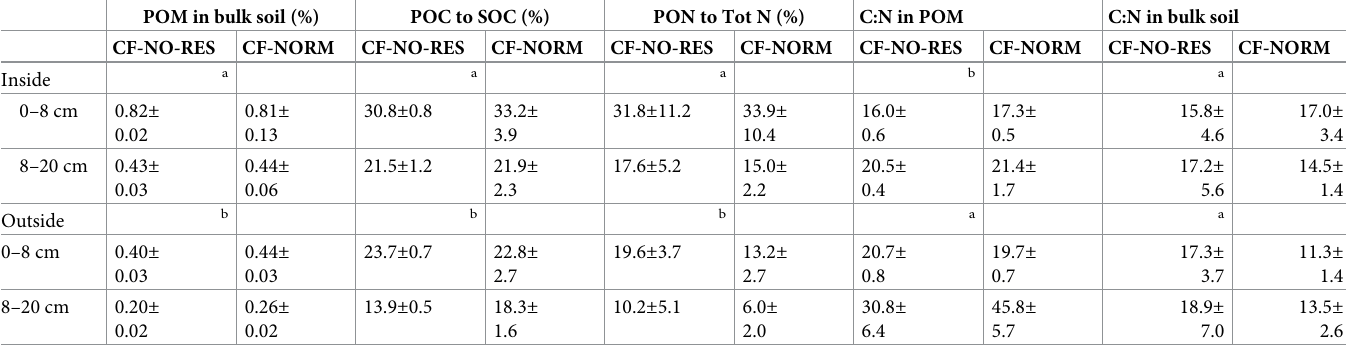
Table 2. Particulate organic matter in the bulk soil, contribution of particulate organic C (POC) to SOC, contribution of particulate organic N (PON) to total N and CN ratio in POM in CF-NORM and CF-NO-RES inside and outside basins at 0 to 8 cm and 8 to 20 cm in 2018. Lowercase letters denote differences in POM and quality of POM between inside and outside basins independent of the soil management treatment. Values are averages with standard errors, n = 4.